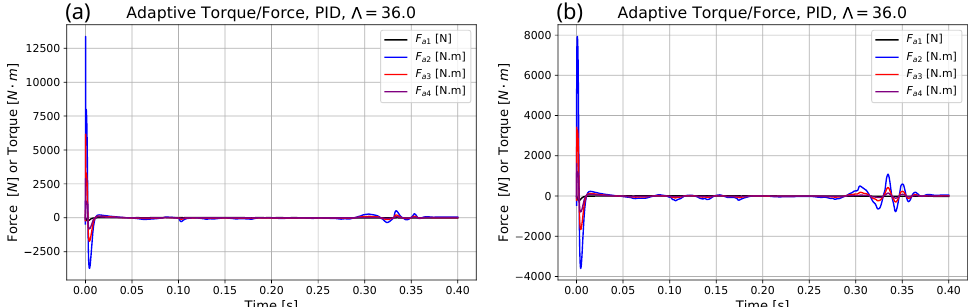
Figure 11. The adaptive control forces without force limitation in full scale. ( a ) For set 1. ( b ) For set